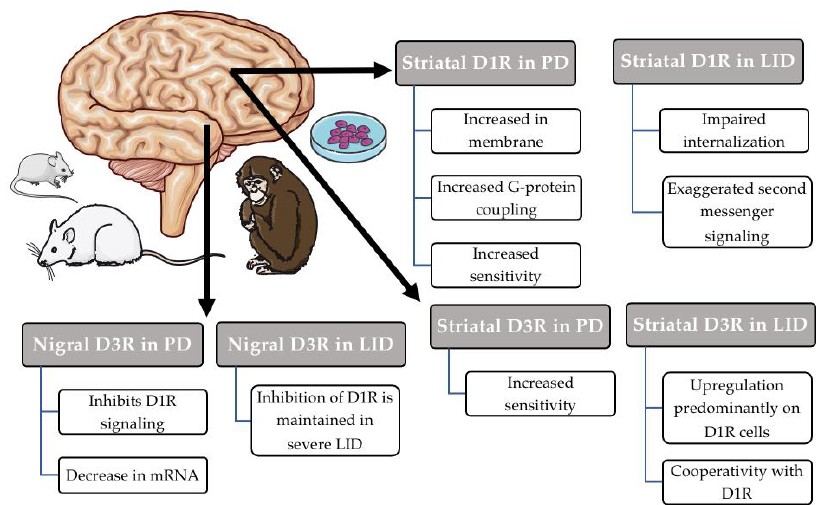
Figure 1. Summary of major changes associated with dopamine D1/D3 receptors in the striatum and nigra. Studies in cells, mice, rats, non-human primates and humans have demonstrated dynamic changes to dopamine receptors D1 (D1R) and D3 (D3R) across Parkinson’s Disease (PD) and L-DOPA-induced dyskinesia (LID). In the denervated state, D1R are sensitized. This is partially achieved by increases in membrane-bound G-protein-coupled D1R. In L-DOPA-induced dyskinesia (LID), D1R are unable to internalize and effectively terminate signaling, leading to further supersensitization and second messenger signaling. Some evidence suggests that striatal D3R are also supersensitive in PD but are expressed at almost undetectable levels. In LID, D3R are upregulated predominantly on D1R cells, where they display cooperativity with D1R at the level of downstream signaling. In contrast, in striatonigral terminals, D3R inhibits D1R signaling in the denervated state. This inhibitory property is maintained in severely (but not mildly) dyskinetic subjects. Image credit: Servier medical art (http://smart.servier.com/; Access date: 15 March